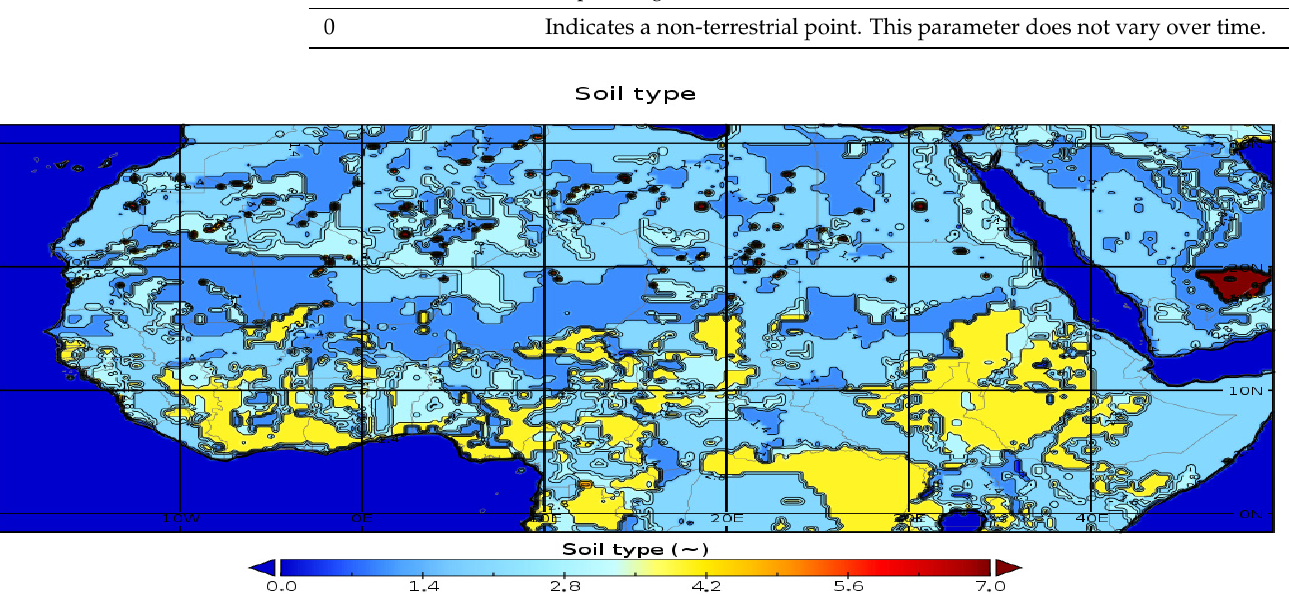
Figure 12. Climatology of lowland land cover evolution (4D-Var ERA5), 1979 to 2008 with a resolu- tion of 0.5 × 0.5 degrees. Data from the ERA5 platform. Indicates a non-terrestrial point. This parameter does not vary over time.